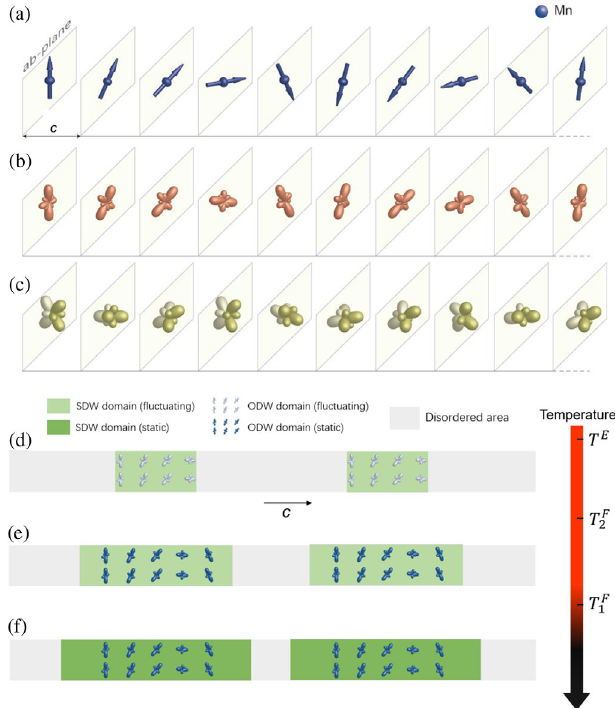
FIG. 5. An illustration of the intertwined orders in MnP. (a) The helical spin density wave with a period of about 8 . 6 c is shown with Mn ions with equal spacing in the c direction. (b) The orbital density wave with 1 = 2 the period is represented by an exagger- ated mixture of d xy and d x 2 − y 2 orbitals that rotates together with the spin but is symmetric under 180° rotation. (c) The orbital density wave with 1 = 3 the period is represented by an exagger- ated mixture of d xz and d yz orbitals that rotates 3 times as fast as the spin. (d) Cartoon showing that short-ranged and fluctuating SDW (represented by the blue area) and ODW domains (repre- sented by the texture) share the same region in MnP for T E ≥ T ≥ T F T F ≥ T ≥ T F 2 . (e) When 2 1 , the ODW is fully devel- oped and stops growing with a decreased temperature, while SDW domains continue to grow. There are regions with fluctu- ating spin order but without orbital order. (f) When T ≤ T F 1 , the spin order is fully